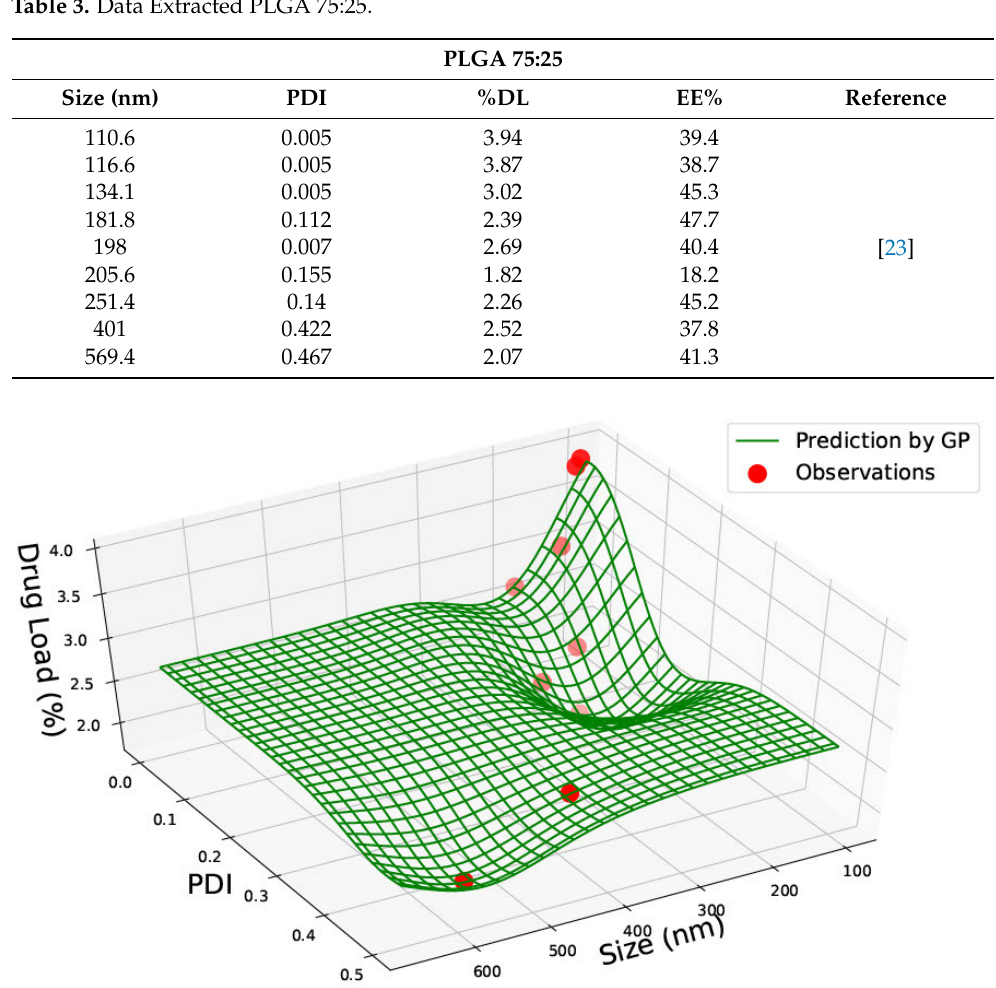
Figure 7. PLGA 75:25—Size (nm), Polydispersity Index (PDI) and Drug Load (DL%). Figure 7 represents PLGA 75:25 nanoparticle data with size, PDI and drug load. It